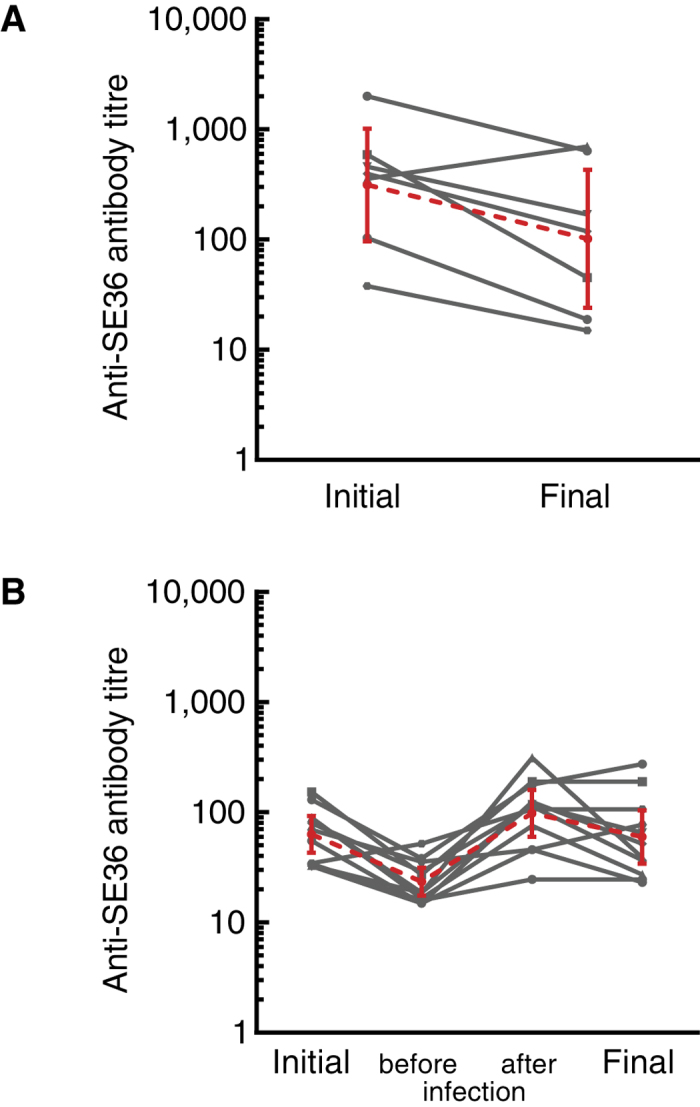
Antibody titre changes in vaccine responders that had (A) no or (B) at least one P. falciparum infection during Day 130–365. Initial, before, after and final denote baseline antibody titres obtained 21 days post-second vaccination, titre at a monthly visit before the observed malaria infection, titre at a monthly visit after malaria infection, and titre at 365 days post-second vaccination, respectively. Lines and markers in red show GM of antibody titres with 95% CI. (A) GM = 314.0 (95% CI, 96.64–1020) and GM = 102.0 (95% CI, 24.16–430.4) for Initial and Final, respectively. (B) GM = 62.8 (95% CI, 42.86–92.01); GM = 20.88 (95% CI, 16.38–26.63); GM = 97.29 (95% CI, 59.46–159.2) and GM = 54.19 (95% CI, 31.47–93.34) for Initial, before infection, after infection and Final, respectively.